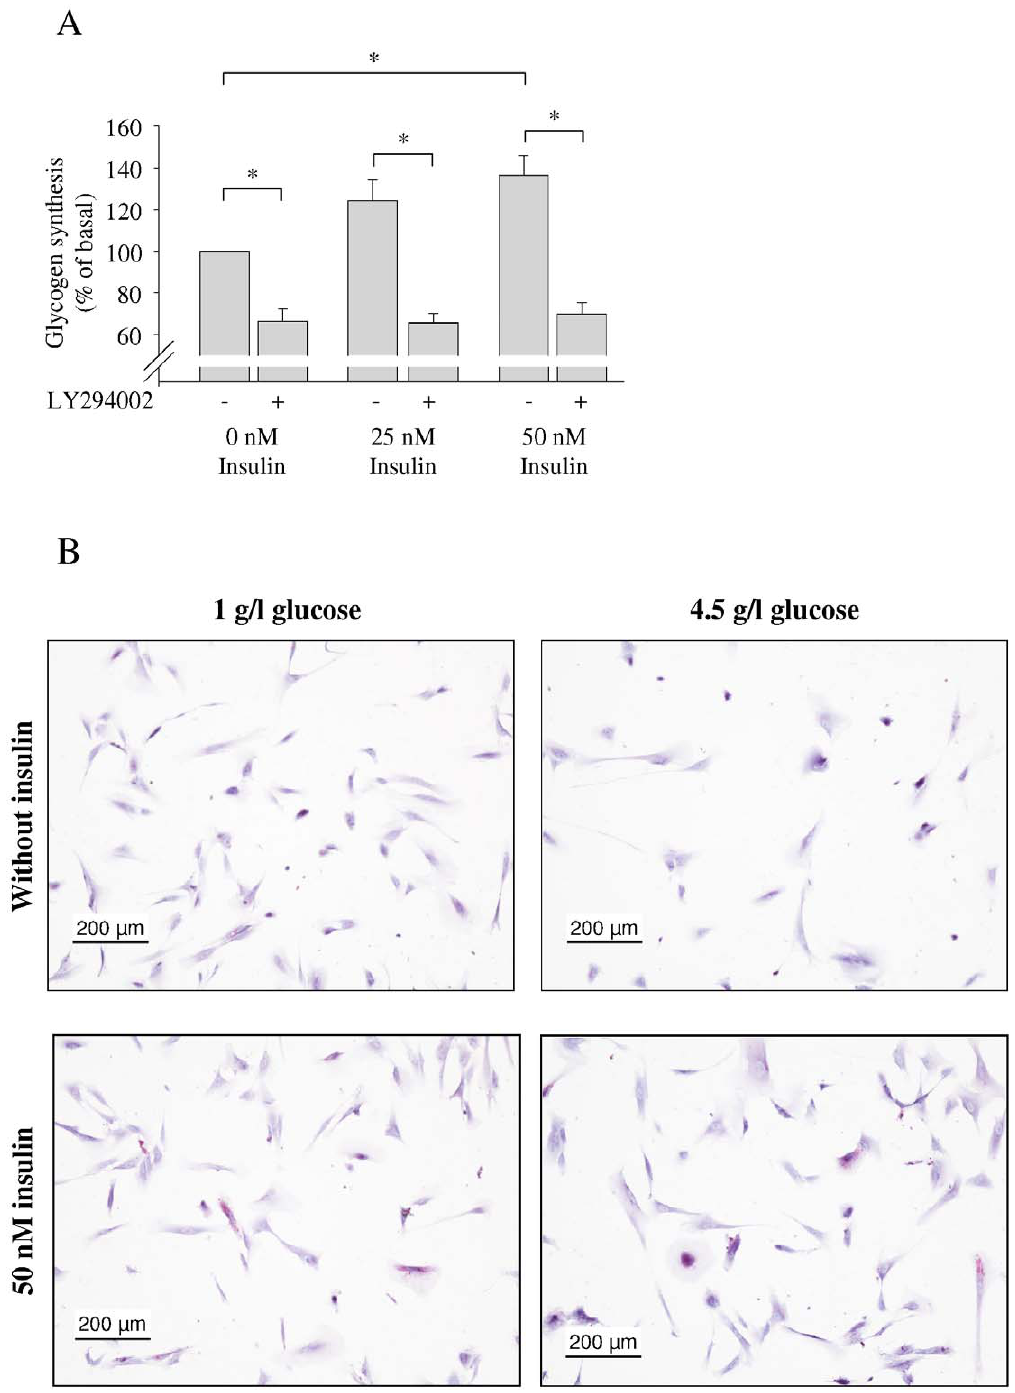
Figure 5. Effects of insulin stimulation on glycogen synthesis (A) and glycogen content (B) of human astrocytes. ( A ) The indicated cells were preincubated with the PI-3 kinase inhibitor LY294002 for 1 hour. Cells were stimulated with the indicated concentrations of insulin for 3 hours. Glycogen synthesis in the absence of insulin and LY294002 was set as 100%. Bars represent means of at five independent experiments + SEM. There were significant differences between the groups (ANOVA, p , 0.0001). * indicates significant difference (Tukey Kramer post hoc test p , 0.05). ( B ) Prior to experiment, NHAs were either starved in medium containing 1 g/l glucose (left lane) or kept in medium with 4.5 g/l (right lane). Medium was than replaced by new medium with the same glucose concentrations without (upper panels) or with 50 nM insulin (lower panels). After three hours of stimulation, cells were stained for glycogen (pink). Shown are representative examples of at least three independent experiments.